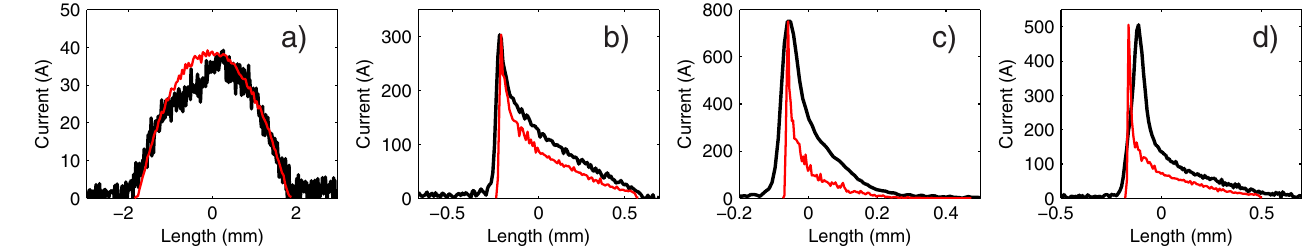
FIG. 6. Instant current profile as a function of the compression phase for the measurements reported in Table I. Simulated profiles ( PARMELA , red curve) are compared to the measured ones (black lines).